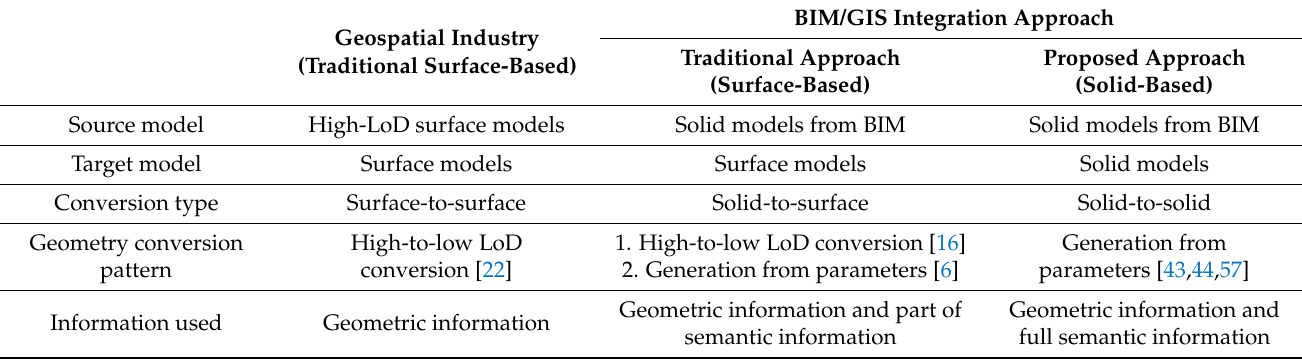
Table 14. Building model simplification in geospatial industry and in BIM/GIS integration.